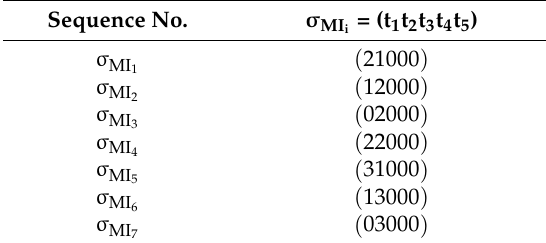
Table 7. Forbidden sequences of Example 2.